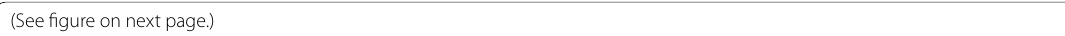
figure on next Fig. 4 Expression of AtSOAR1 in rice alters global transcriptomic profiles as determined by RNA‑seq analysis. A Volcano plots showing the status of differential expressed genes between different comparison groups. Red dots represent up‑regulated genes and blue dots represent down‑regulated genes. Horizontal axis and vertical axis represent the Log2 of fold change and the adjusted P value (FDR) of indicated genes, respectively. WT‑S/WT, salt‑treated WT relative to WT without treatment; OE/WT, OE‑1 relative to WT without treatment; OE‑S/OE, salt‑treated OE‑1 relative to OE‑1 without treatment; OE‑S/WT‑S, salt‑treated OE‑1 relative to salt‑treated WT. B Statistics of pathway enrichment of differential expressed genes between OE‑1 and WT under salt treatment. Each dot represents a KEGG pathway as indicated at the vertical axis. Horizontal axis is rich factor of which value represent significance of enrich level to a certain pathway of differential expressed transcripts. C Heat map showing the clustering of the differentially expressed genes of the four comparisons groups. The clustering was drawn based on the normalized, log‑scaled FPKM (fragments per kilo base of exon per million reads mapped) values. D Validation of the representative differential expressed genes by qPCR and semi‑quantitative RT‑PCR. The bands from left to right indicates WT without treatment, OE‑1 without treatment, salt‑treated WT and salt‑treated OE‑1, respectively. Hydroponic cultured two‑week‑old seedlings were treated with 140 mM NaCl for 2 d before sampled for total RNA extraction and cDNA synthesis. Actin1 was used for internal control and all the values are means SE from three independent biological ±